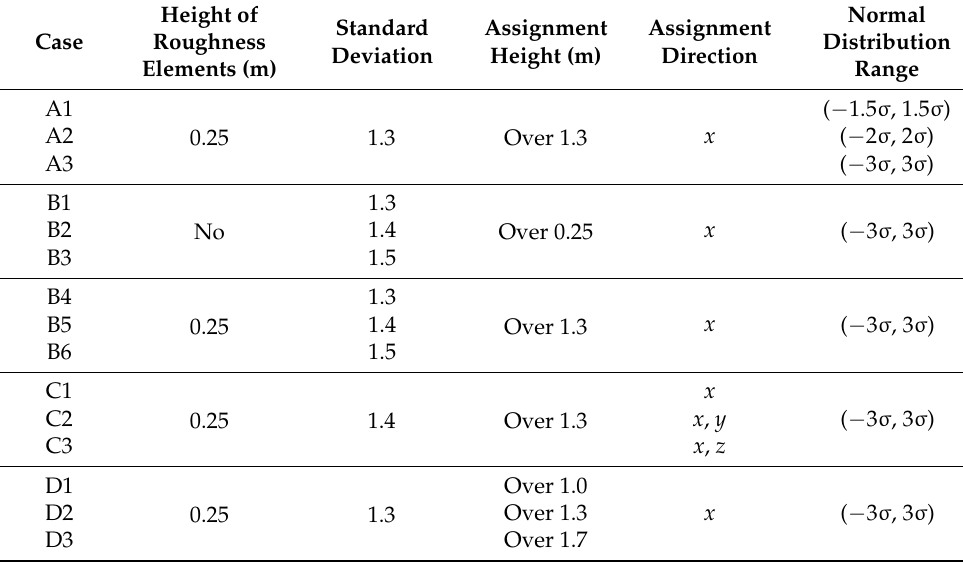
Table 4. Case details of random number